Question: Author a descriptive caption for the visualization shown.
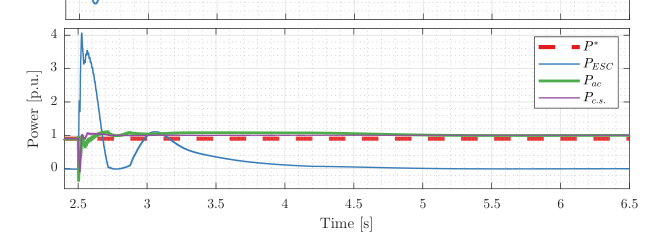
Answer: Phase-Jump of −80 deg. followed by RoCoF while discharging — Top: ac currents in [p.u.] with Is base; Middle: ac frequency in [Hz]; Bottom: active powers in [p.u.] with Sbase.